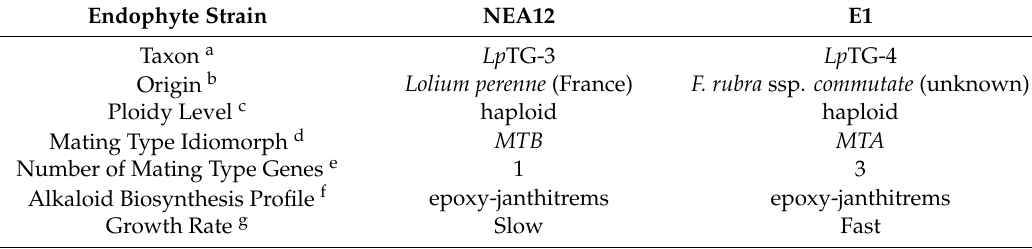
Table 1. Properties of selected asexual Epichloë endophytes used for transgenic